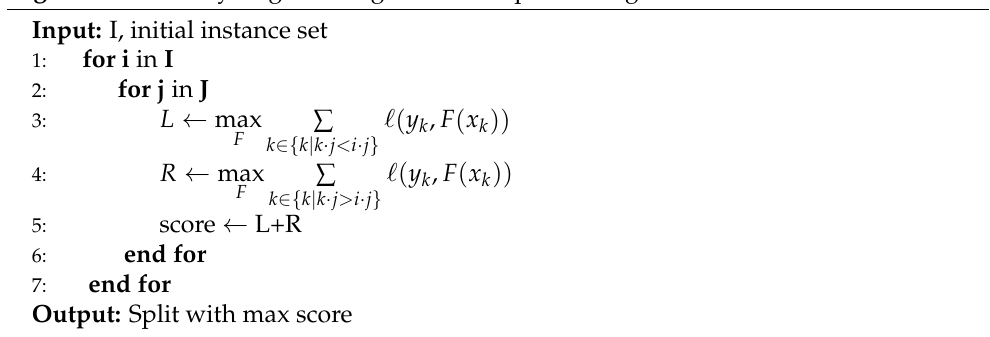
Figure 3. Box-plots of the PM 2.5 maxima at 26 monitoring stations in the Mexico City metropoli- tan area. Algorithm 1 Greedy stagewise algorithm for split